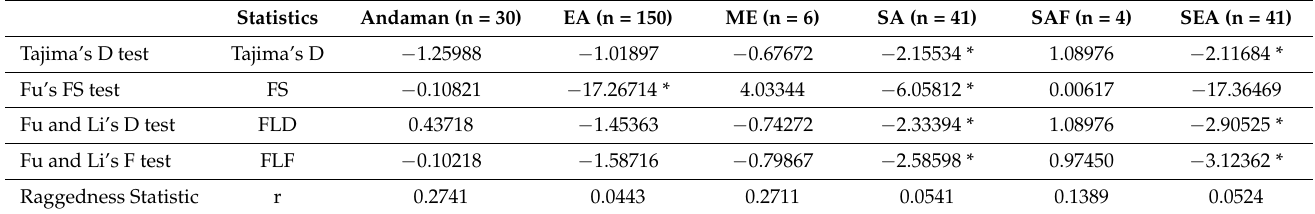
Table 5. Neutrality tests of haplogroup B goats of Andaman and other